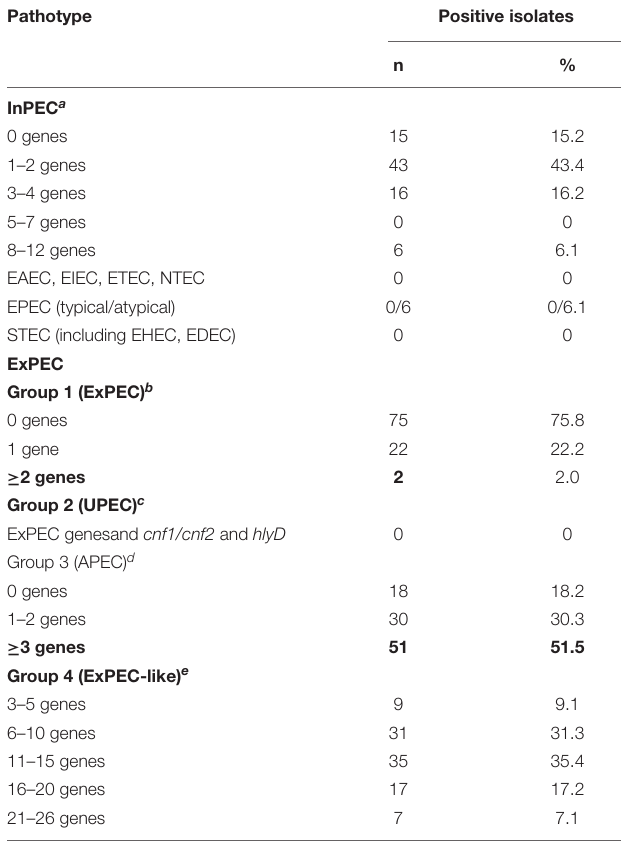
TABLE 3 | Distribution of InPEC- and ExPEC-related virulence-associated genes (VAGs) in ESC-non-S/ESC-R E. coli isolates.